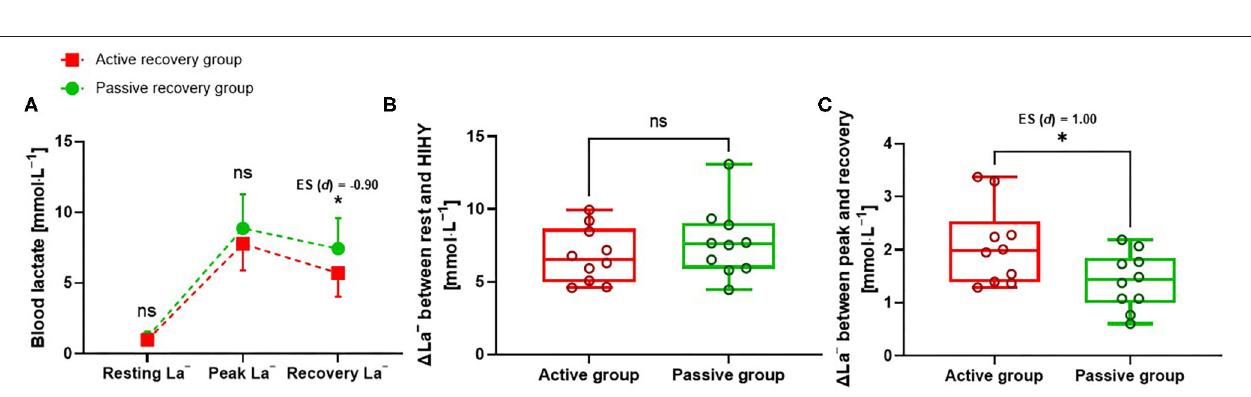
FIGURE 4 | (A) Blood lactate concentration for active recovery group and passive recovery group, before high-intensity hatha yoga (HIHY) (resting La − ), after high-intensity hatha yoga (peak La − ), after 10-min recovery (recovery La − ), (B) Change in lactate concentration ( 1 La − ) between resting blood lactate and peak blood lactate after high-intensity hatha yoga, (C) Change in lactate concentration ( 1 La − ) between peak blood lactate after high-intensity hatha yoga and blood lactate after 10-min recovery. Data are minimum to maximum and median values. ns: p > 0.05, * p <